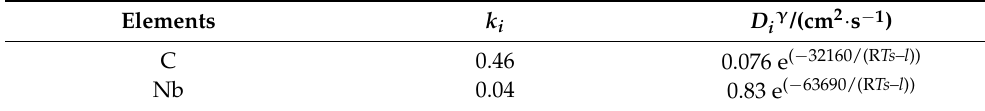
Table 3. Values of equilibrium partition coefficients as well as diffusion coefficients in austenite